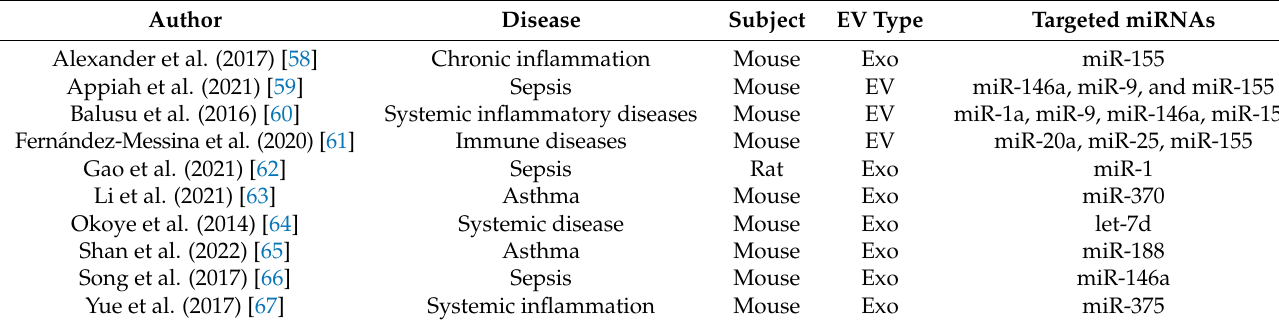
Table 2. Extracellular miRNAs in immune